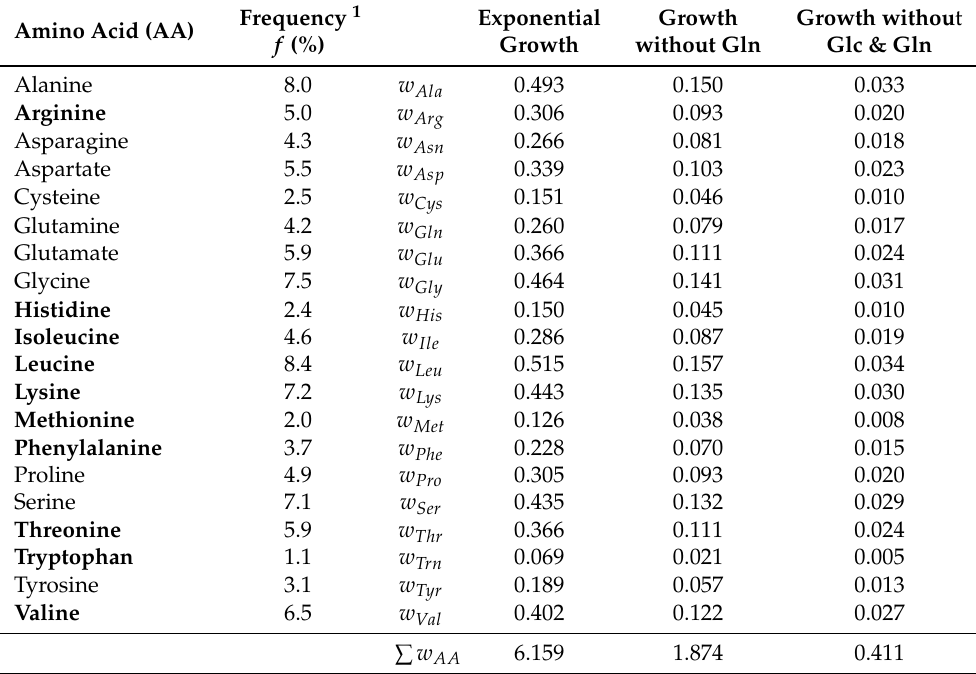
Table 5. Specific consumption rates of amino acids (AA) for protein production [ µ M/d × 10 7 cell]. (Essential AA are in